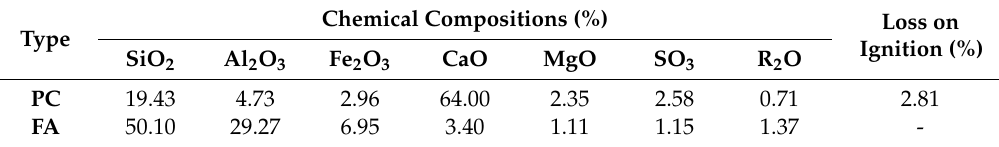
Table 1. Chemical compositions of PC clinker and fly ash